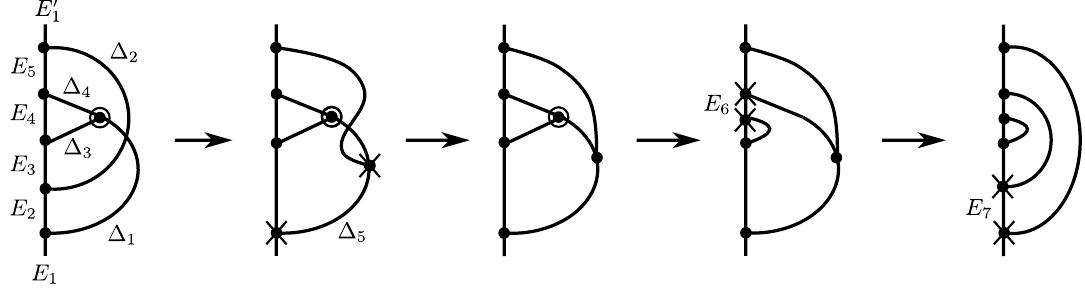
Figure 9 . An application of our diagrammatic rules involving the reduction steps shown in (cid:12)gure 8. At each step, new vertices are marked with a cross and only new propagators are